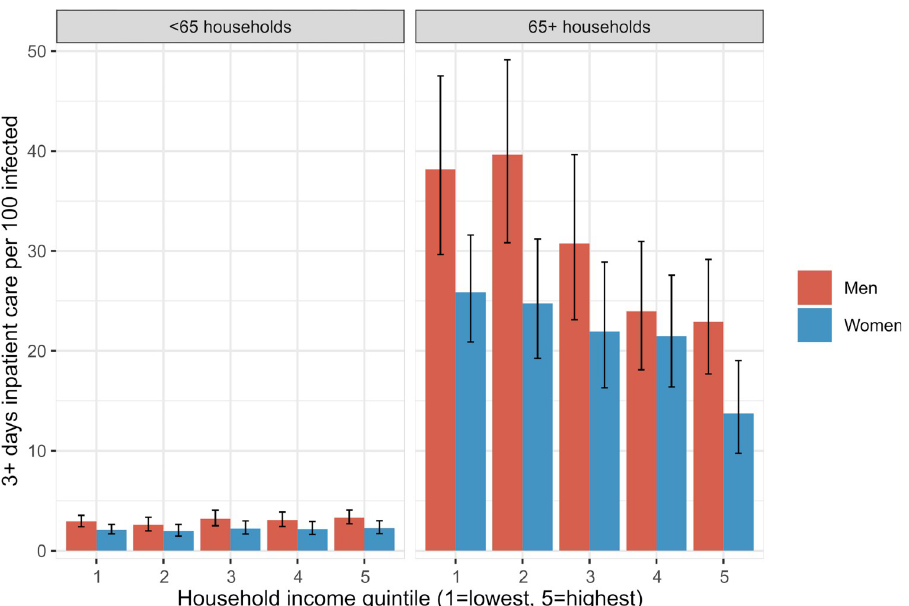
Fig 3. Incidence of severe COVID-19 illness among those infected by sex and household income. Incidence defined as 3+ days in hospital per 100 among those infected ( n = 24,138) from 1 July to 31 December 2020 among individuals living in households with people aged under 65 and over 65. The whiskers represent 95% confidence intervals.